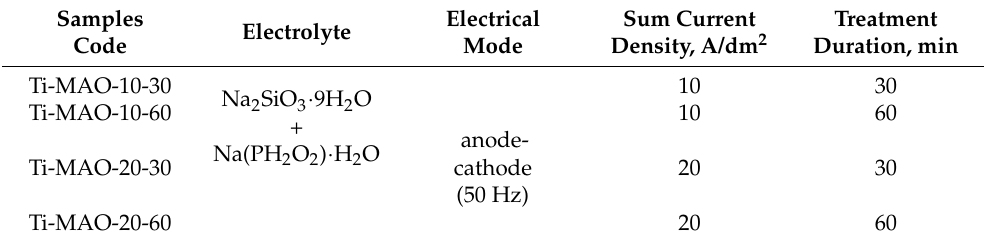
Table 2. The samples code and main technological parameters of the MAO process. Samples